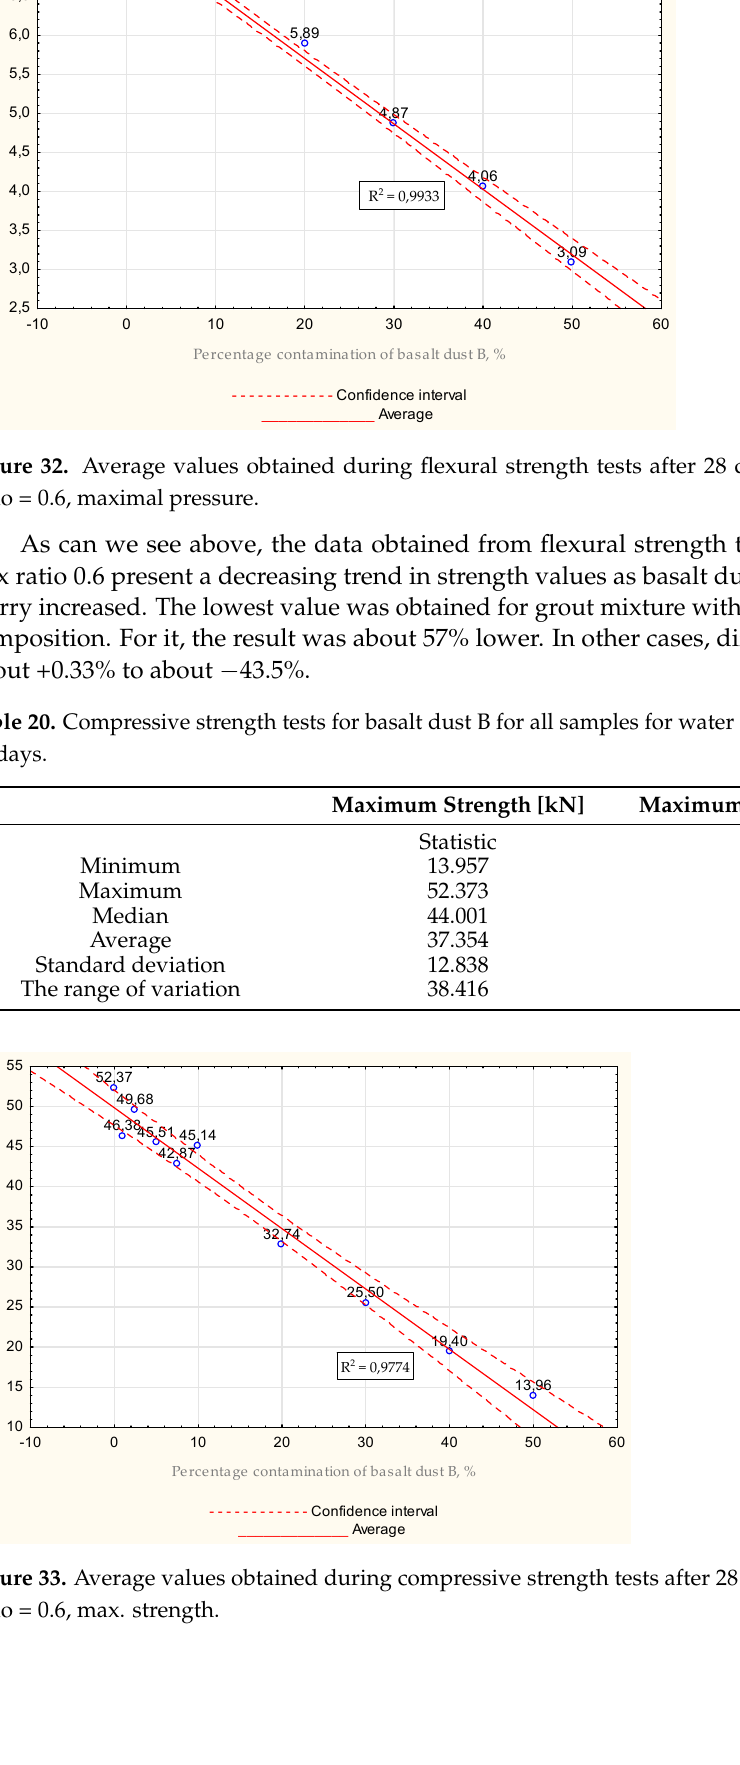
= 0.6, maximal strength.